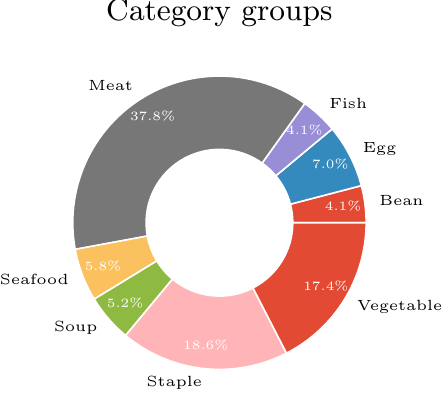
Figure 6. Distribution of food categories under eight groups from VireoFood-172 dataset